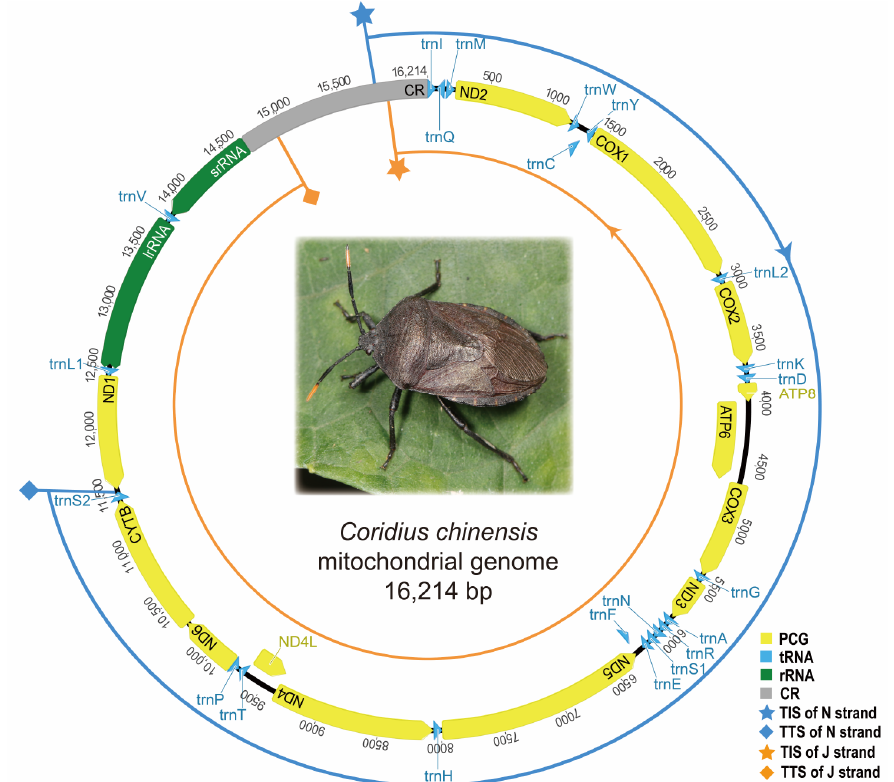
Figure 3. The proposed models of mitochondrial transcription in C. chinensis . The blue and orange curves represent the polycistronic primary transcripts of N and J strands, respectively. The orientation of transcription is shown by the arrows.